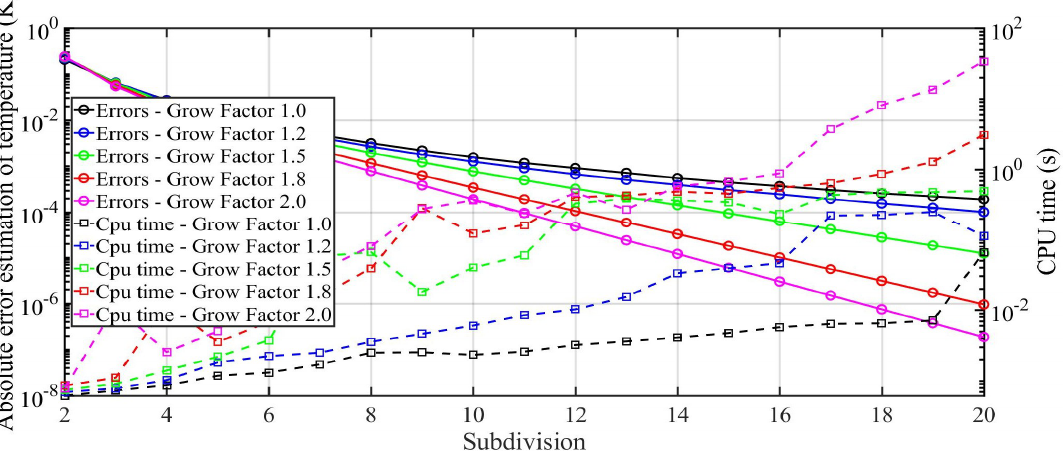
Figure 9. Absolute maximum temperature error estimations of the outer surface (Case 1).